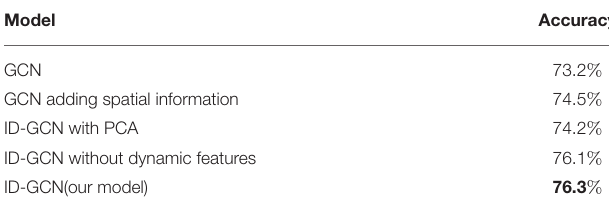
TABLE 5 | Ablation study on the effects of different components.